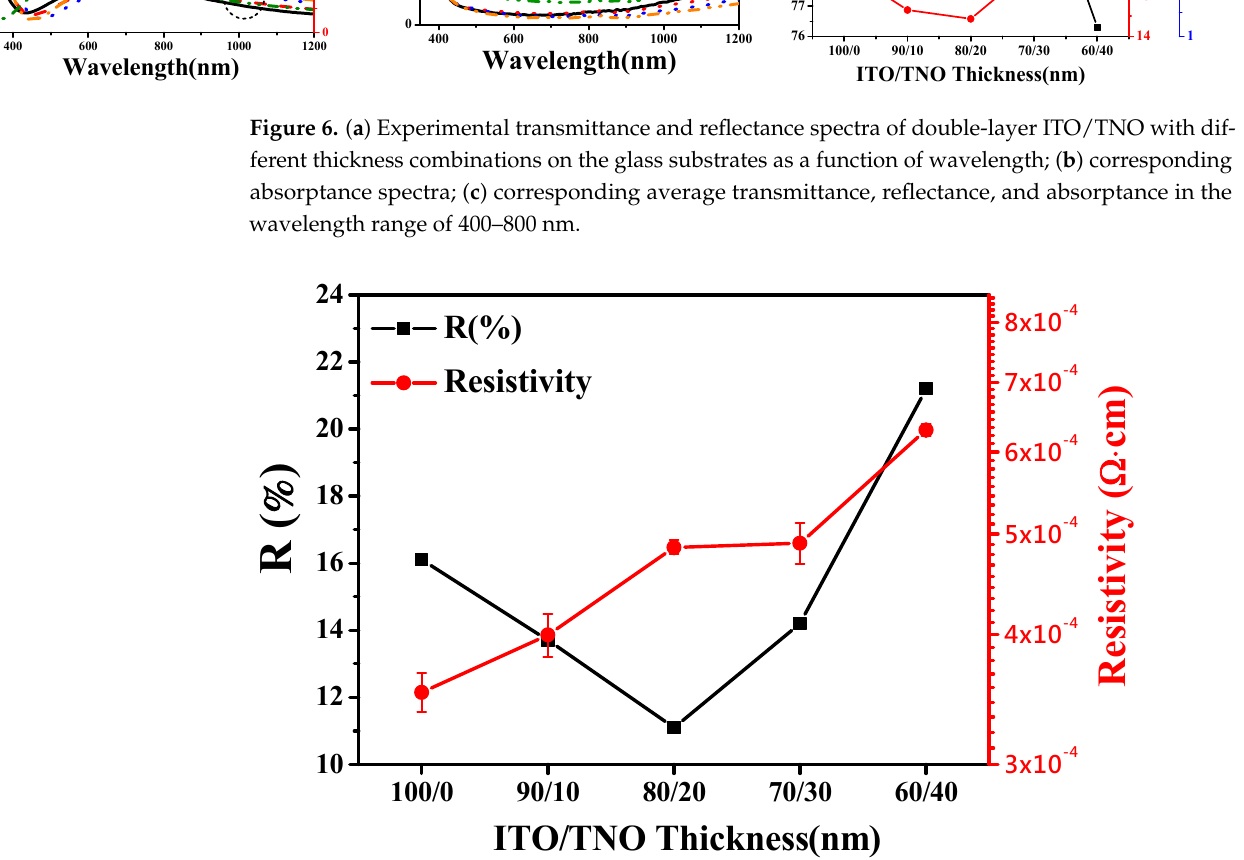
Figure 7. Trends of reflectance at the center wavelength of 550 nm and resistivity for double-layer ITO/TNO with different thickness combinations deposited on the glass substrates.